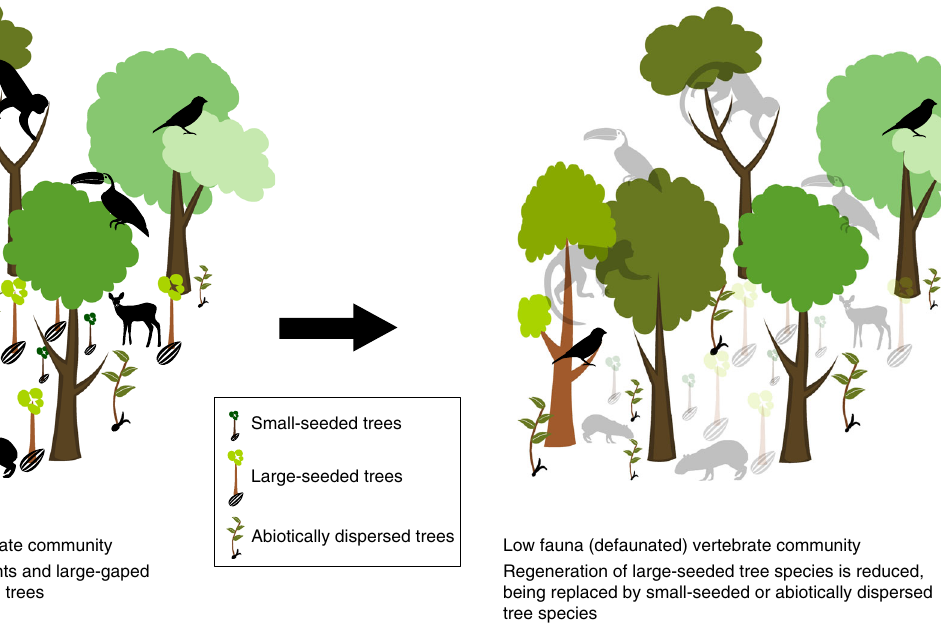
Fig. 5 Schematic representation of forest regeneration in natural and defaunated